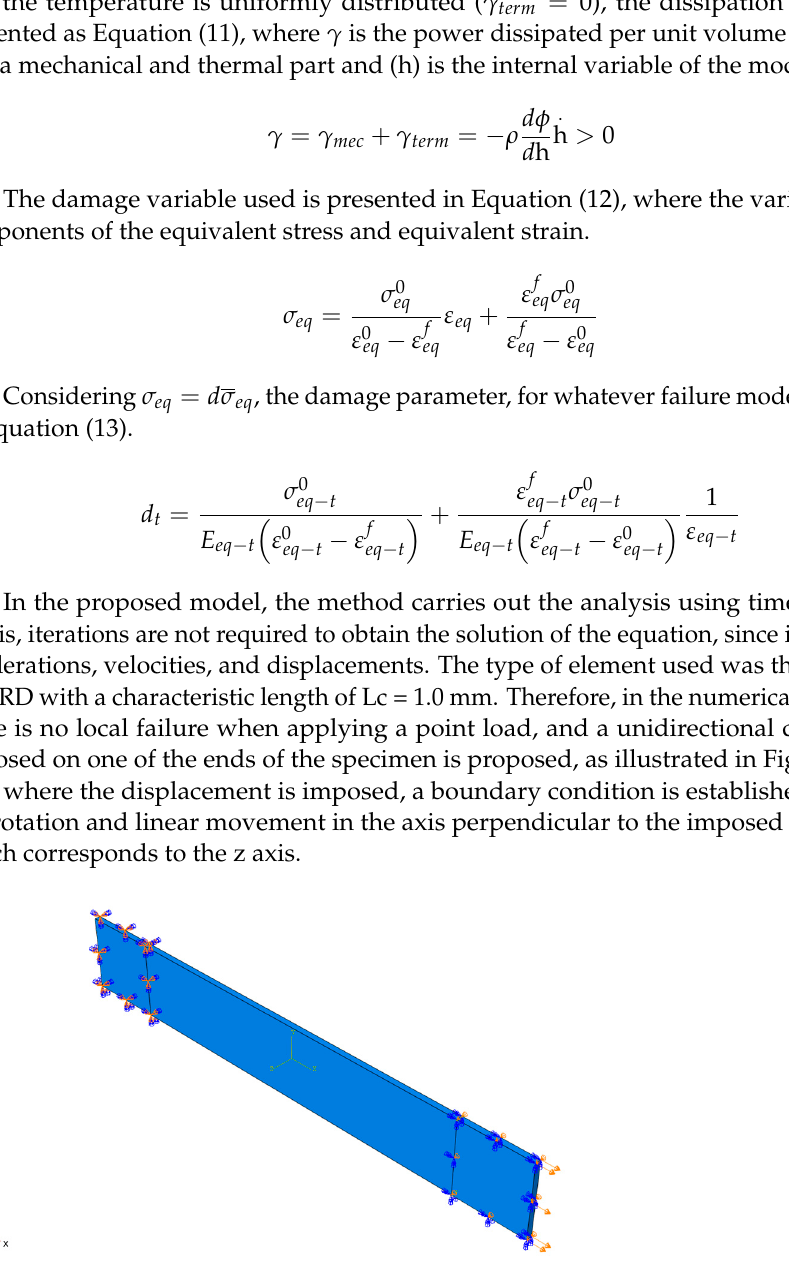
Figure 5. Boundary conditions in the computational model.